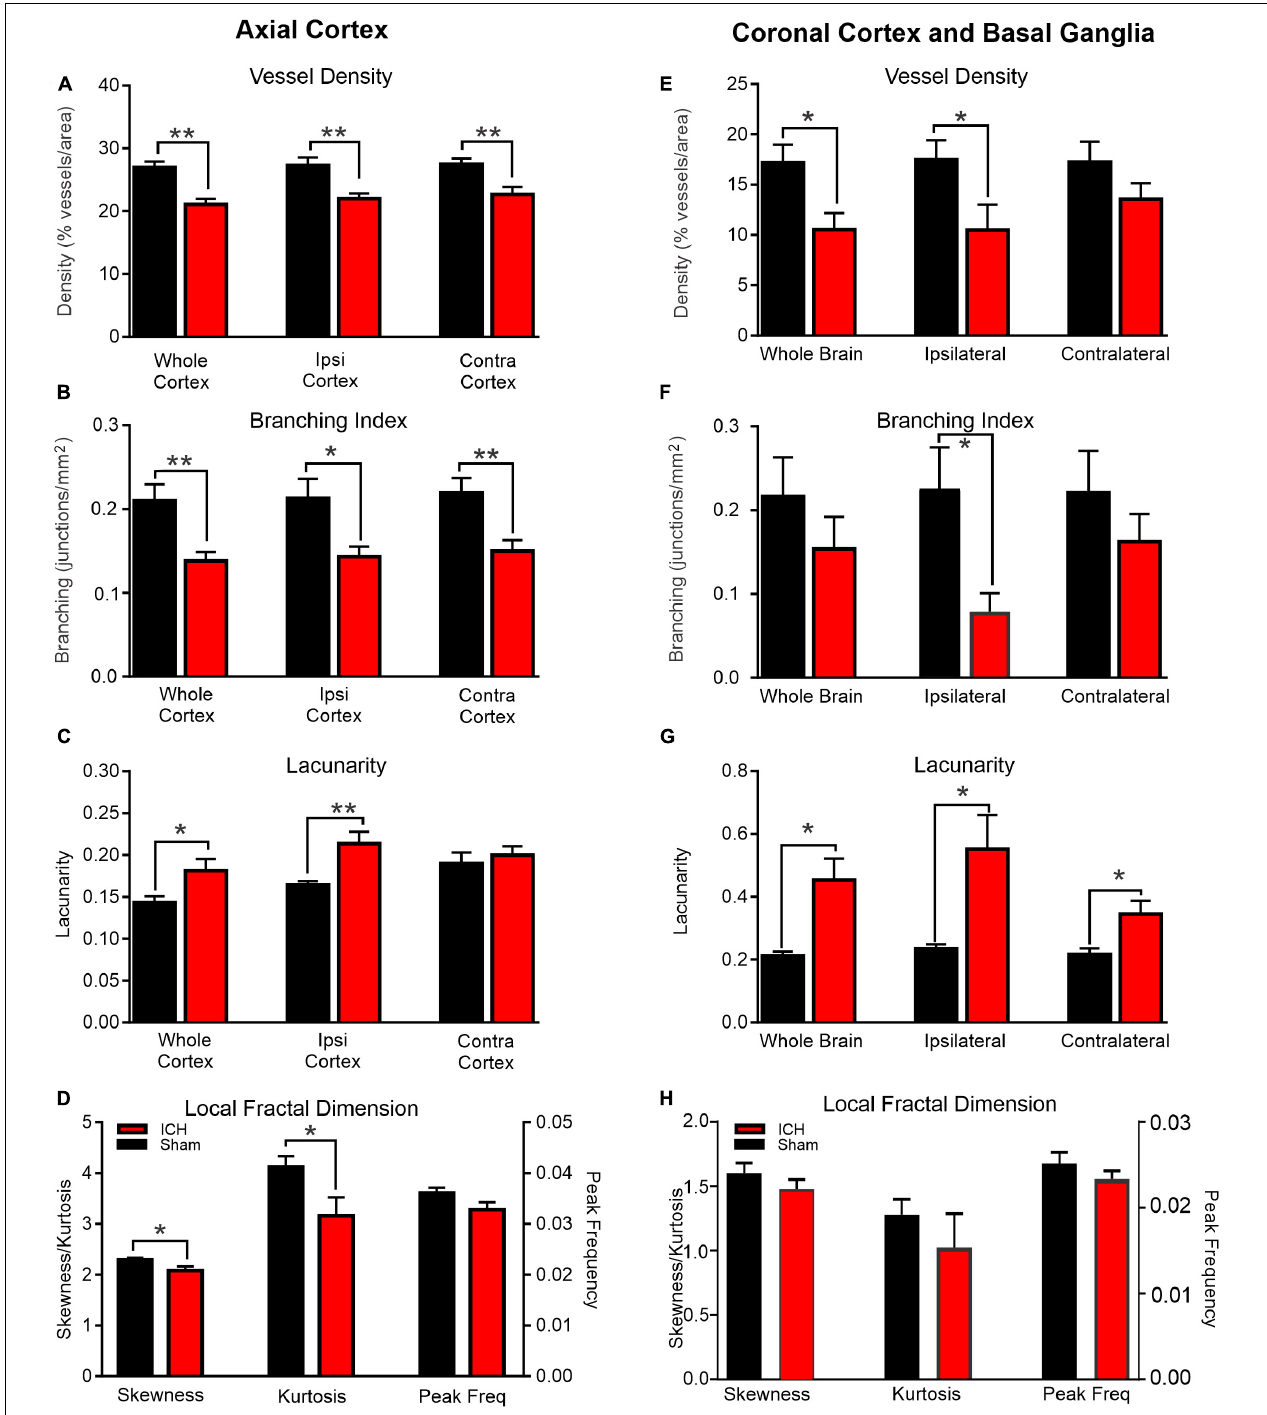
FIGURE 2 | ICH induces modification of vascular features at 24 h post-injury. Axial Cortex: Classical vascular analysis of the entire axial cortex, ipsilateral (Ipsi) and contralateral (Contra) cortical hemispheres resulted in significant reductions in vessel density (A) and branching index (B) after ICH compared to shams. There was a concomitant increase in lacunarity (C) but not in the contralateral hemisphere. Fractal derived vascular complexity of the ipsilateral cortex using local fractal dimension histograms (LFD) (D) exhibited significant decrements in skewness and kurtosis between shams and ICH animals. Coronal Cortex and Basal Ganglia: Classical vascular analysis of coronal vessel painted sections at the level of the ICH lesion revealed significant reductions in vessel density (E) and reduced branching indices (F) . There was a dramatic increase in lacunarity (G) . Quantitative analysis of the LFD histograms from the ipsilateral cortex and basal ganglia exhibited no significant changes in skewness, kurtosis or peak frequency (H) in ICH vehicle compared to sham vehicle animals ( t -test ** p < 0.03, * p < 0.05).